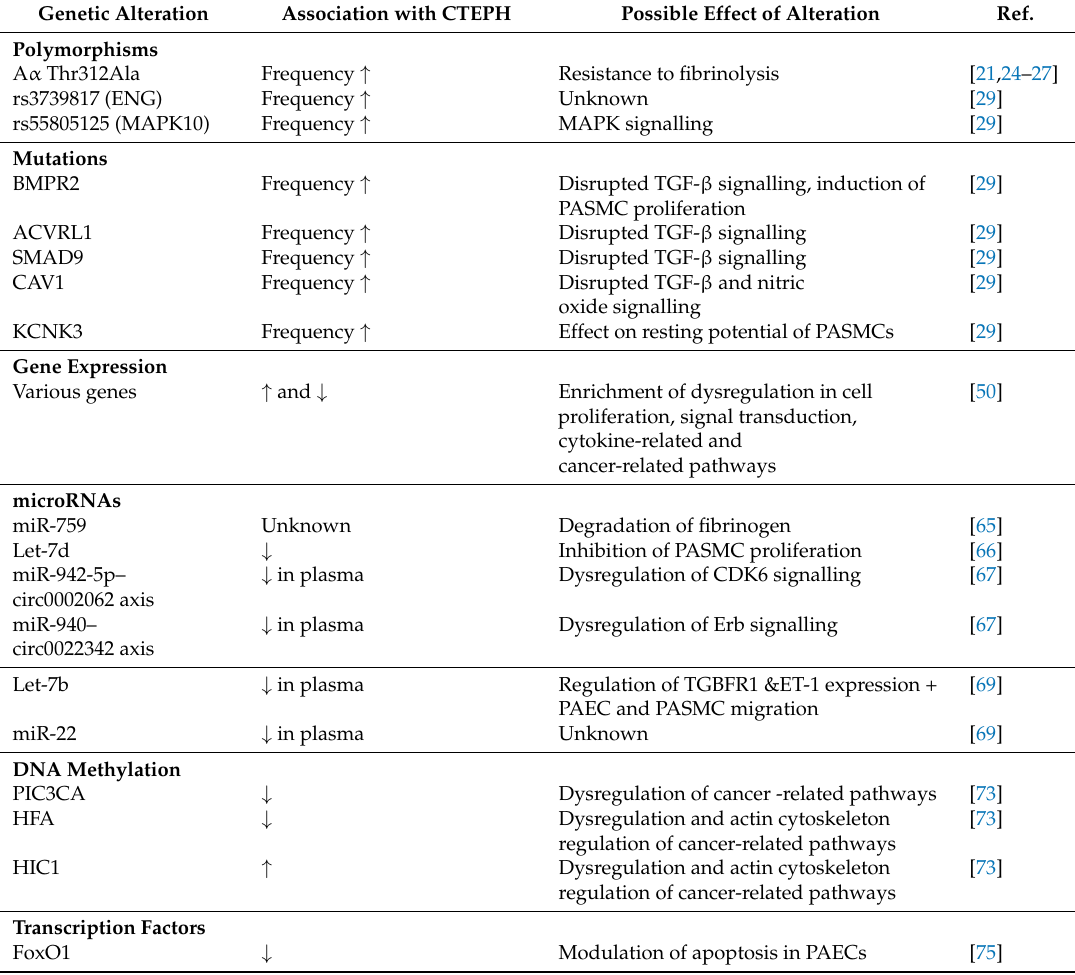
Table 1. Overview of genetic alterations proposed to be associated with